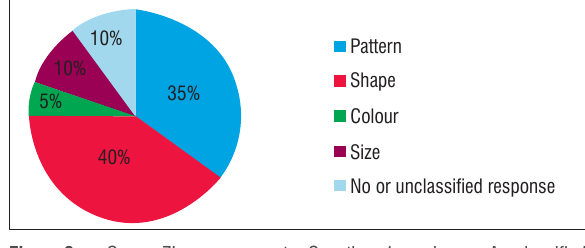
Figure 3: Group Z’s responses to Question 1 on image A, classified accor ding to Bertin’s descriptors.